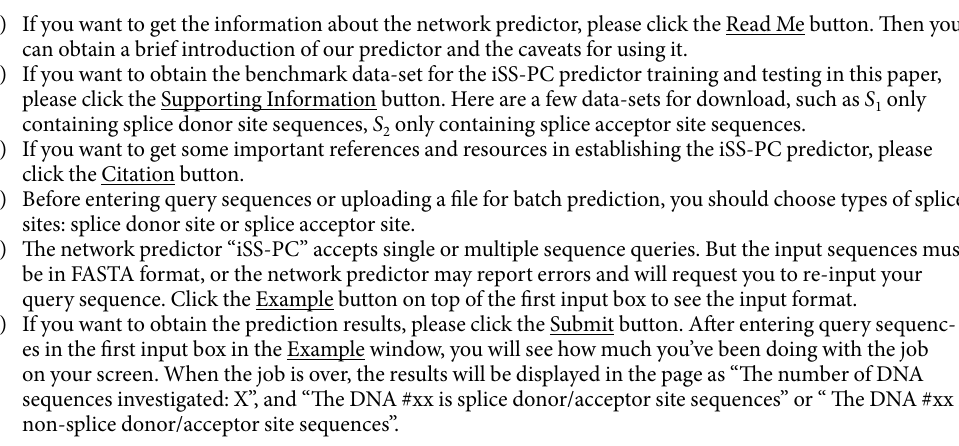
Table 6. The 5-fold cross-validation test results obtained from different classification algorithms with the same feature extraction method on benchmark data-set only containing splice acceptor site sequences. a The predictor with SAE proposed in this paper. b The predictor with SVM created in WEKA with the default parameters. c The predictor with Random Forest (RF) created in WEKA. d The predictor with an ensemble classifier